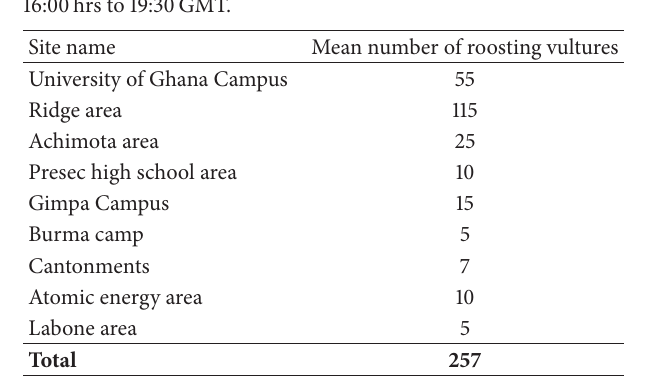
Table1:RoostcountsofverifiedactiveroostsitesofHoodedVulture